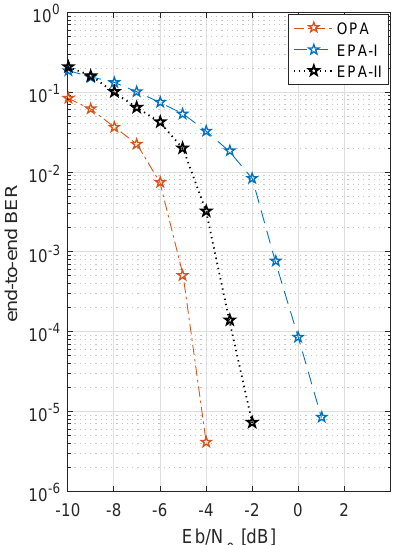
Figure 12. BER of multiple relays (five relays) with three PA (power allocation) schemes, (independent but not identically distributed (n.i.i.d) channels), and